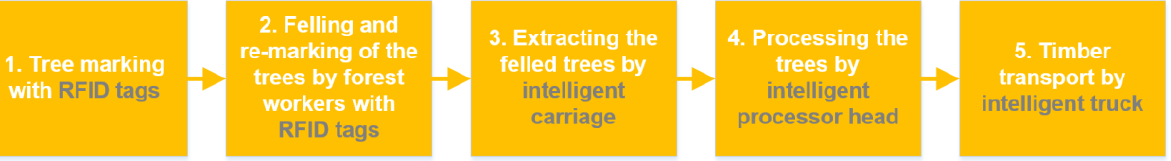
Figure 1. Flow chart: “Processes of the New Timber Tracking and Processing System”. The processes are highlighted in white, and the tools and machines in grey.